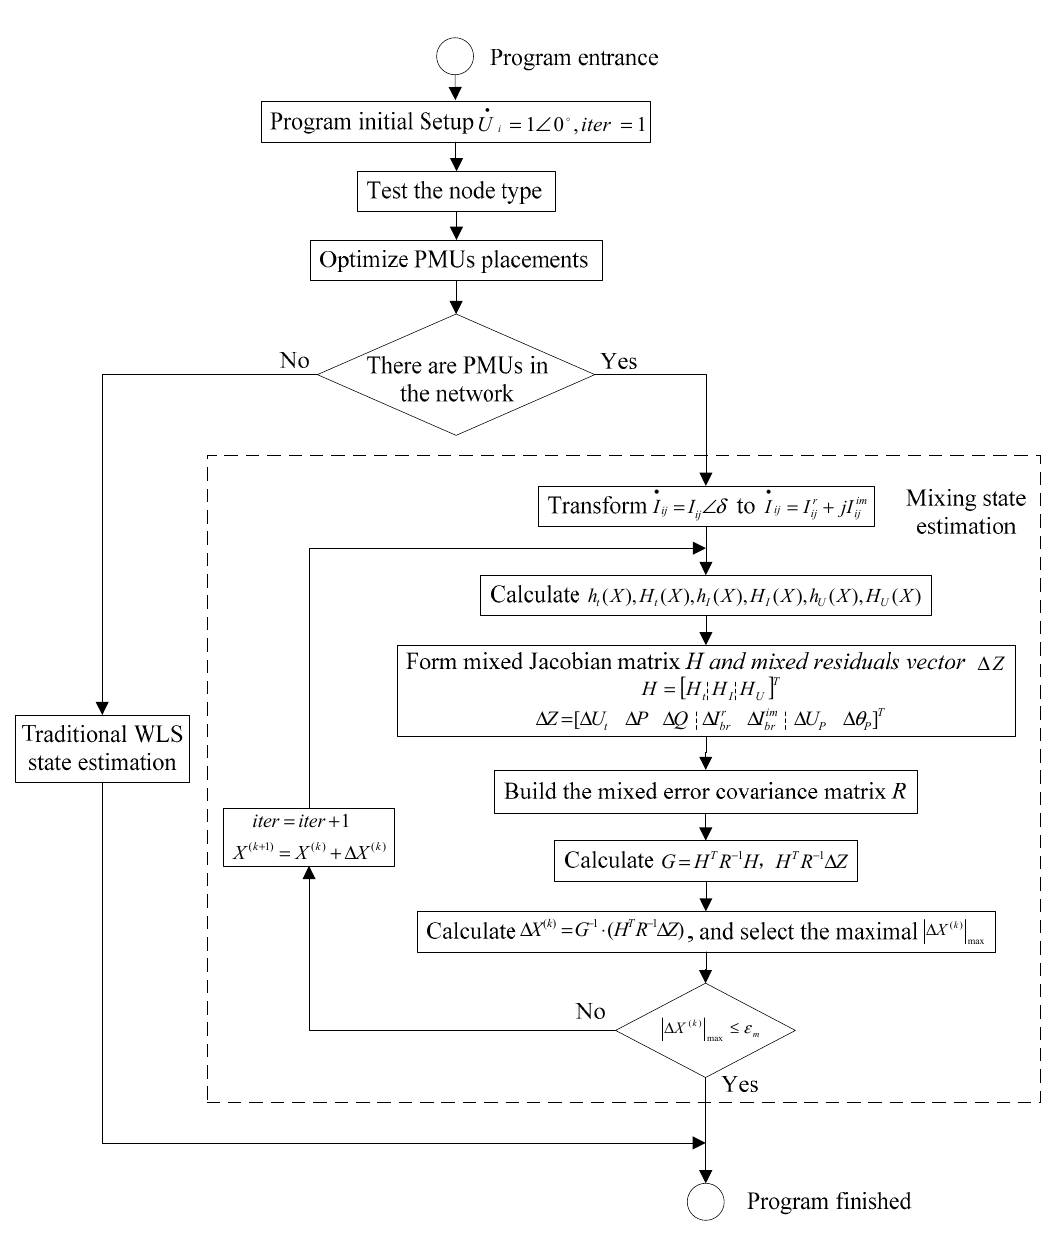
Figure 7. Flow chart of the proposed power system state estimation.